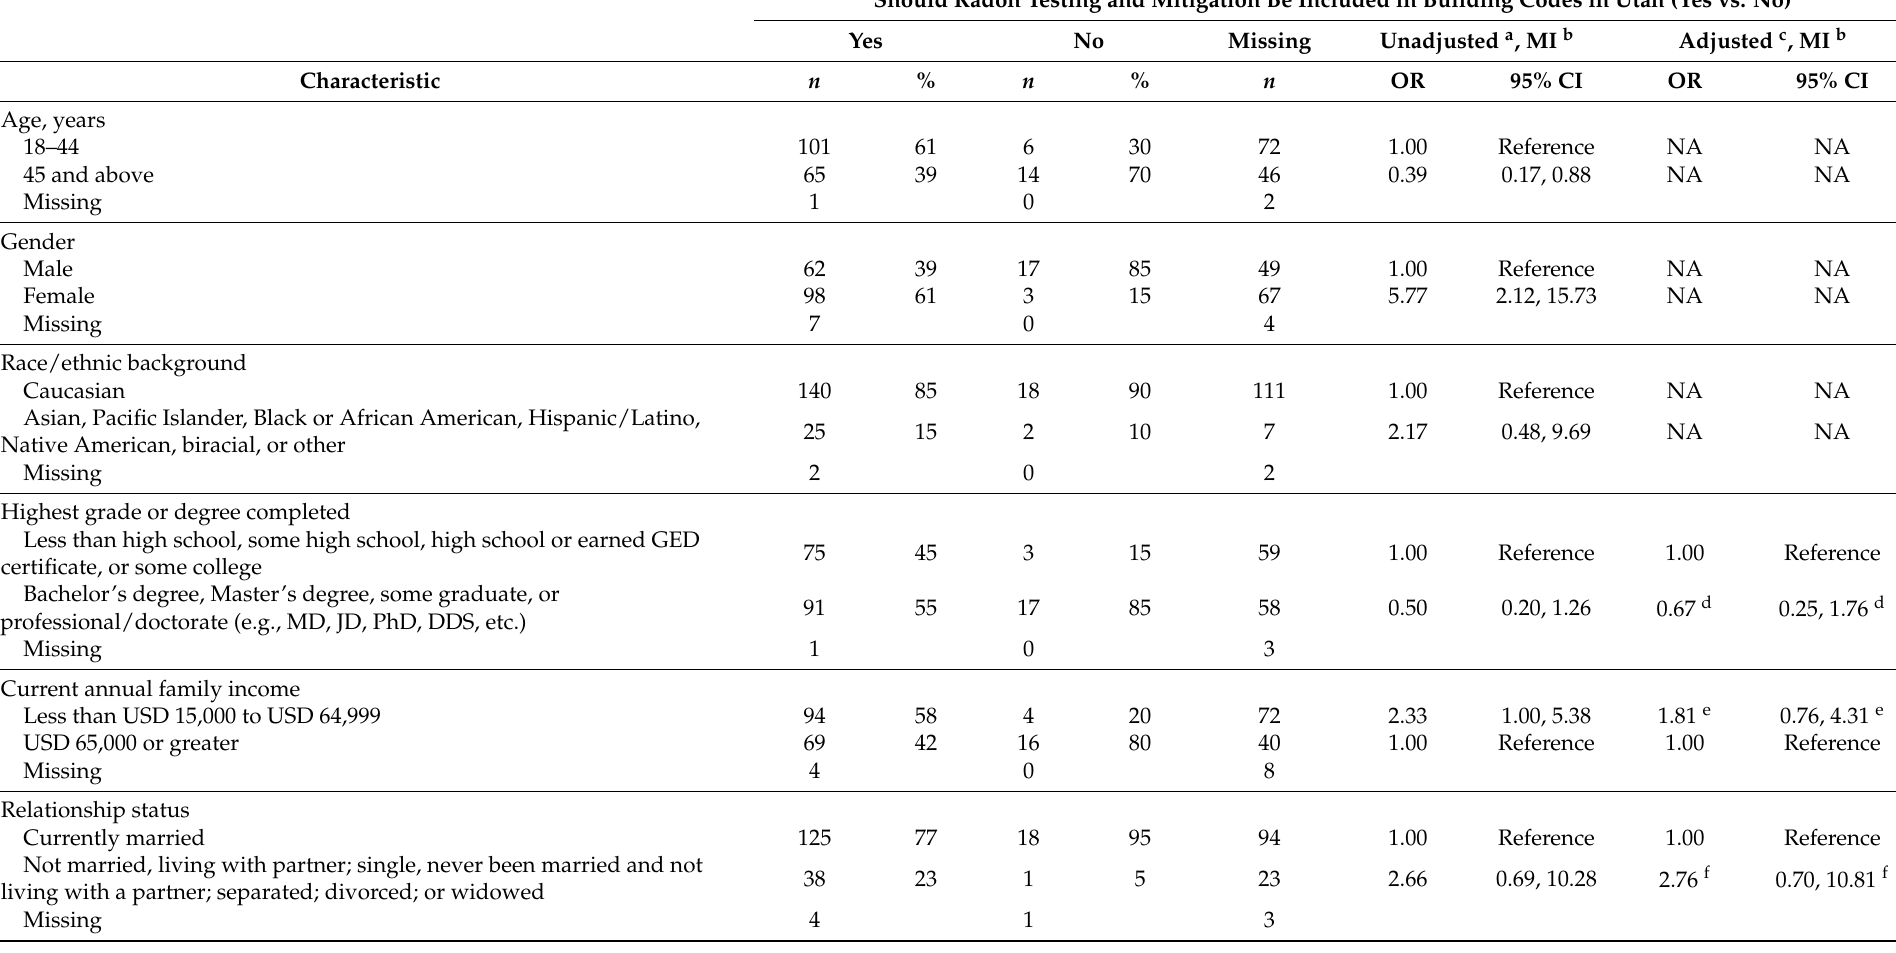
Table 5. Unadjusted and adjusted, multiply imputed associations between characteristics and opinions regarding whether radon testing and mitigation should be included in building codes in Utah among radon testing survey participants, Utah County, Utah, May 2014–January 2016. Should Radon Testing and Mitigation Be Included in Building Codes in Utah (Yes vs.